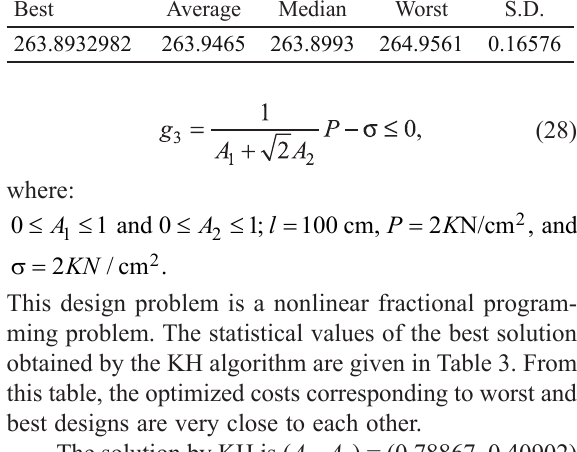
Fig. 2. Three bar truss Table 3. Statistical results of the best three bar truss model